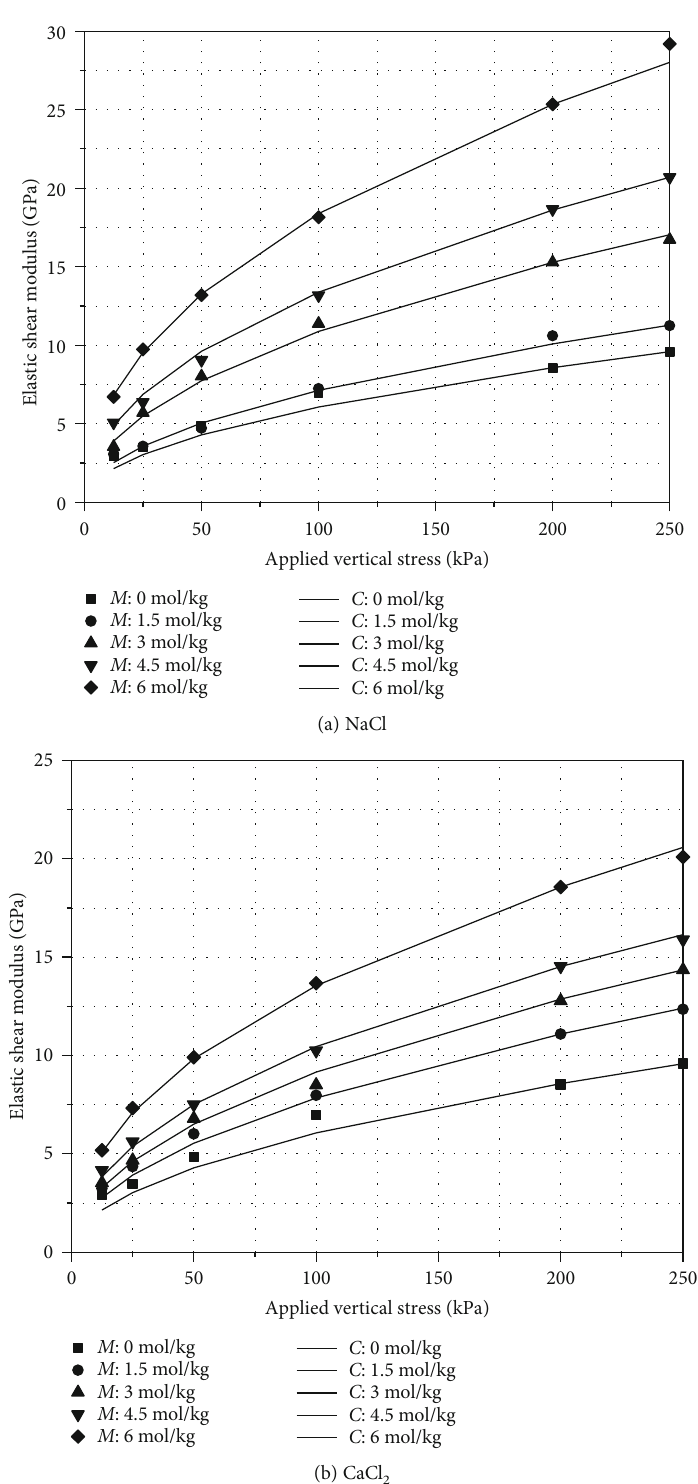
Figure 13: Validation of the G model under di ff erent salinity conditions. M : measured values; C : calculated 0